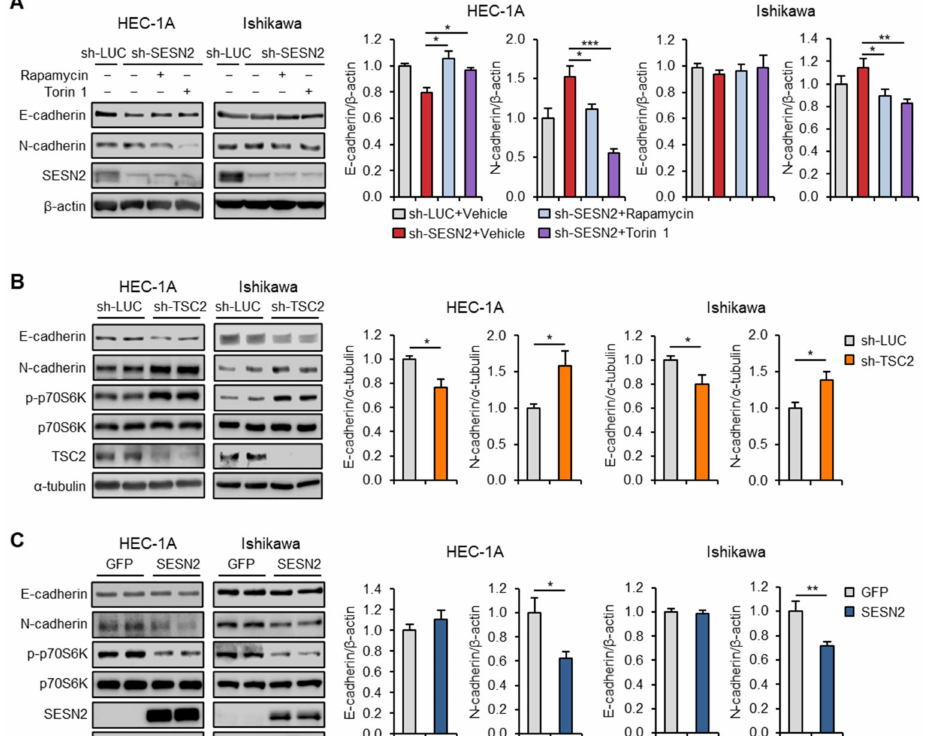
Figure 7. SESN2 regulates E-cadherin and N-cadherin via the mTORC1 pathway in HEC-1A and Ishikawa cells. ( A ) Immunoblotting analysis of E-cadherin, N-cadherin, and SESN2 in HEC-1A and Ishikawa cells infected with lentiviruses expressing shRNAs targeting luciferase (sh- LUC ) or SESN2 (sh- SESN2 ) and treated with 100 nM rapamycin or 250 nM Torin 1 for 24 h. Cell lysates were immunoblotted with anti-E-cadherin, anti-N-cadherin, and anti-SESN2 antibodies. ( B ) Immunoblotting analysis of E-cadherin, N-cadherin, and mTORC1-related proteins in HEC-1A and Ishikawa cells infected with sh- LUC or sh- TSC2 lentivirus. Cell lysates were immunoblotted with anti-E-cadherin, anti-N-cadherin, anti-p-p70S6K, anti-p70S6K, and anti-TSC2 antibodies. ( C ) Immunoblotting analysis in HEC-1A and Ishikawa cells infected with lentiviruses overexpressing green fluorescent protein (GFP) as control or SESN2 . Cell lysates were immunoblotted with anti-E-cadherin, anti-N-cadherin, anti-p-p70S6K, anti-p70S6K, and anti-SESN2 antibodies. β -Actin or α -tubulin served as a loading control. Band intensities were quantified and normalized with β -actin or α -tubulin values. Data are shown as mean ± SEM. Results are representative of at least three independent experiments. * p < 0.05; ** p < 0.01; *** p < 0.001 (Student’s t